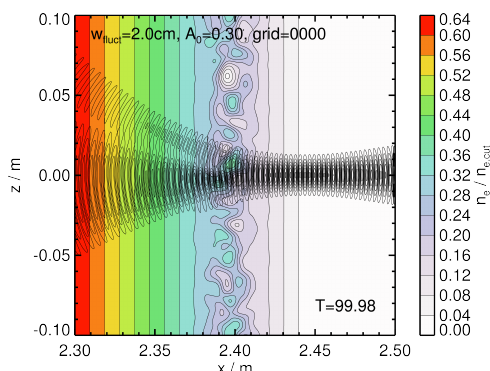
Figure 1. Full-wave simulation grid with colored contour levels indicating the electron plasma density and contour lines indicat- ing the absolute wave electric field. Shown is a sample from the ensemble with the average fluctuation parameters given in the plot. The snapshot is taken from a video published at [24].